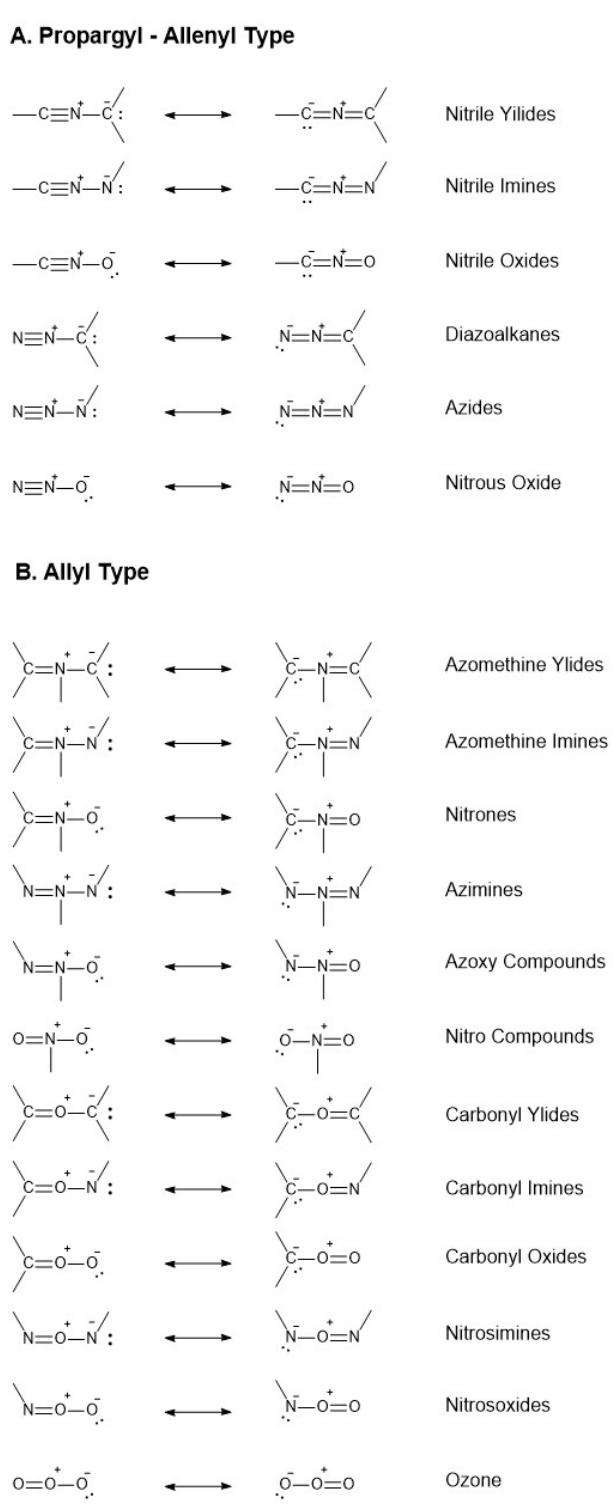
Figure 6. From Huisgen, R. J. Org. Chem. 1976 , 41 ,